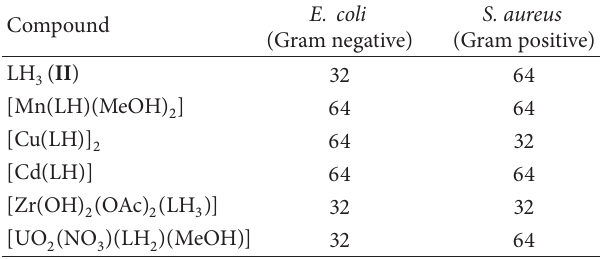
Table4:Minimuminhibitoryconcentration(MIC)ofligand( I )and its coordination compounds ( 𝜇